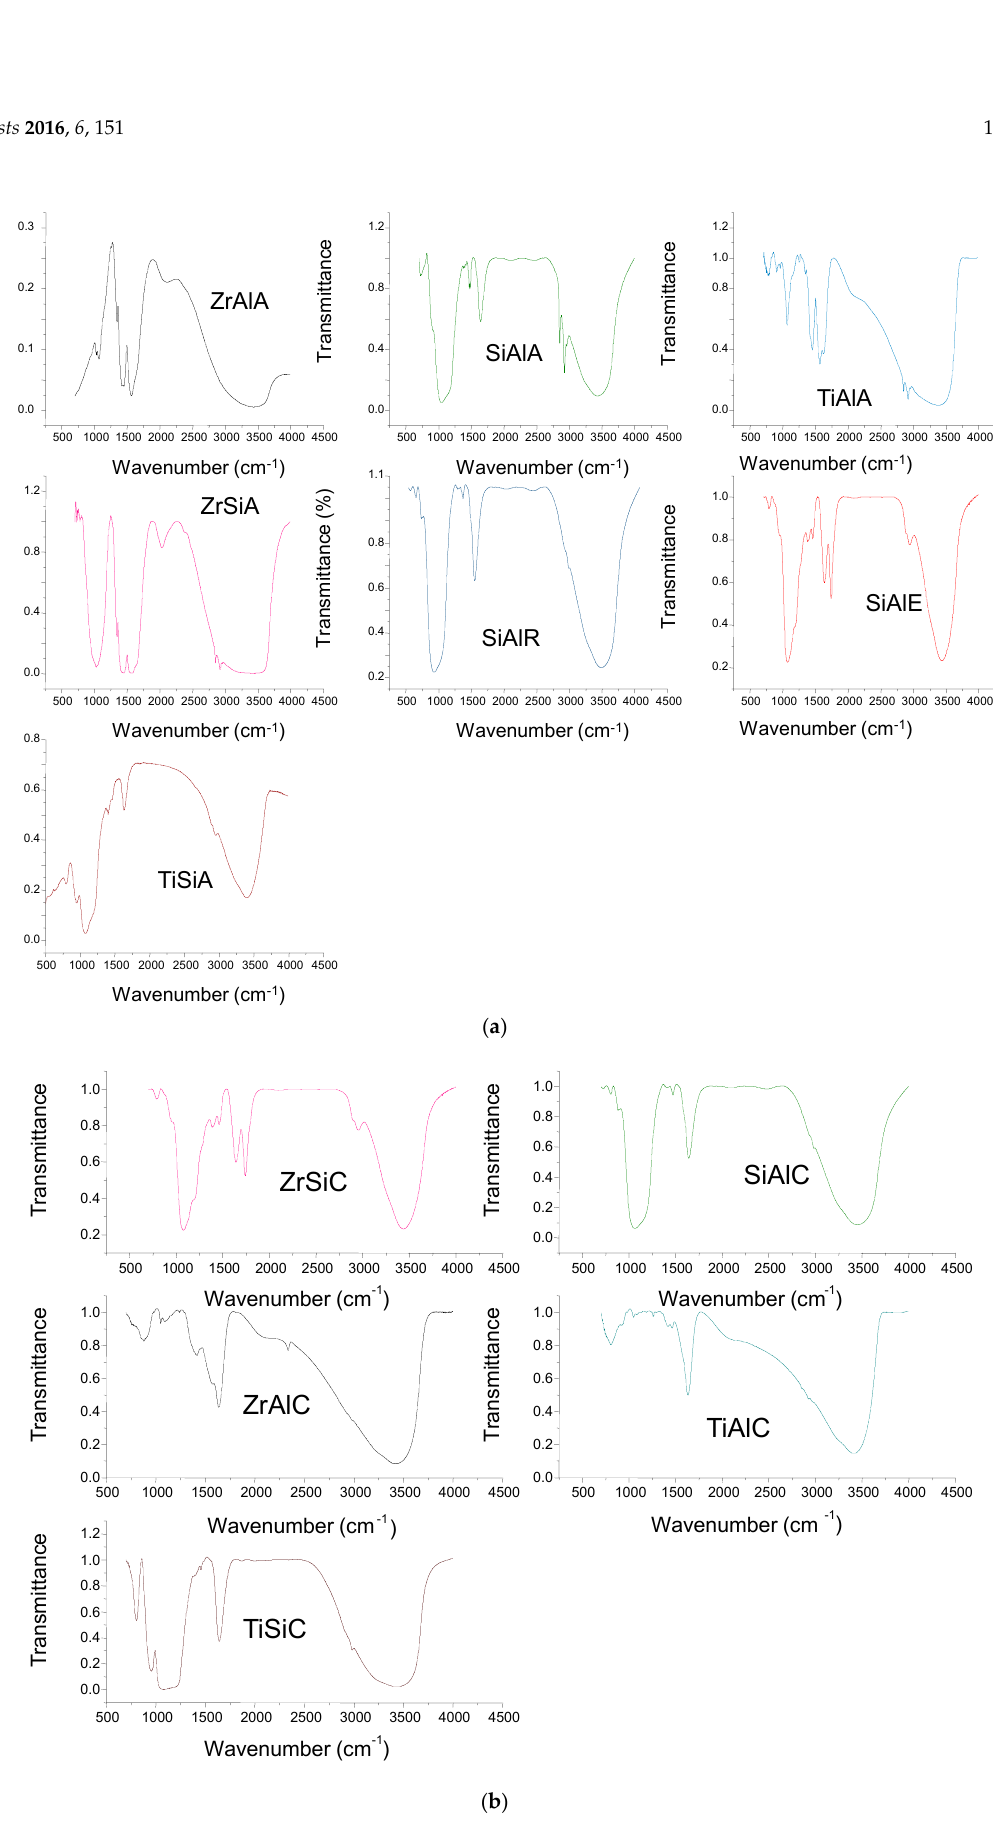
Figure 4. FTIR spectra of selected samples : ( a ) as-prepared and modified samples; ( b ) calcined samples.